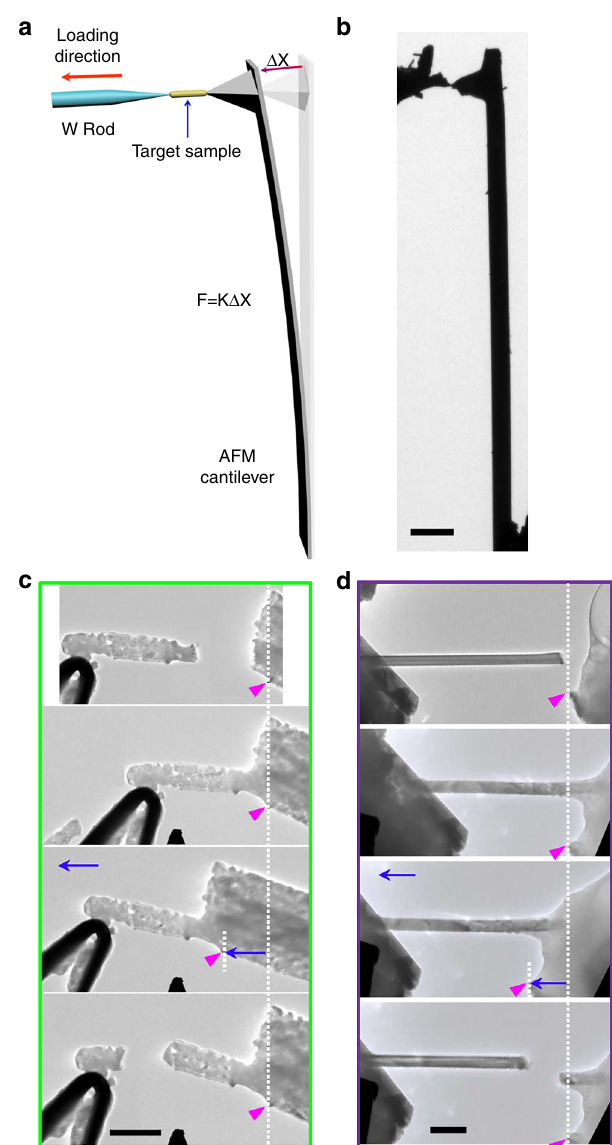
Fig. 4 In situ tensile tests of ceramic nanowires using ceramic nanowelding. a The schematic of a self-assembled in situ TEM-AFM device for the tensile test. The target sample was fi rst welded to the W tip, and then welded to the tip of the AFM cantilever. We stretched the W tip, and the welded sample moved along the same direction, meanwhile the AFM cantilever was bent. Through measuring the de fl ection of the AFM cantilever, we can calculate the tensile strength of the sample. b A real image of the experiment setup. c The tensile test for the pristine MgO nanowires, and the maximum moving distance of the W tip is 1 μ m. The weld junction is composed of nanocrystalline MgO. d The tensile test for a ceramic CuO nanowire, and the maximum moving distance of the W tip is 228 nm. Scale bars: ( b ) 10 μ m; ( c ) 1 μ m; ( d ) 200